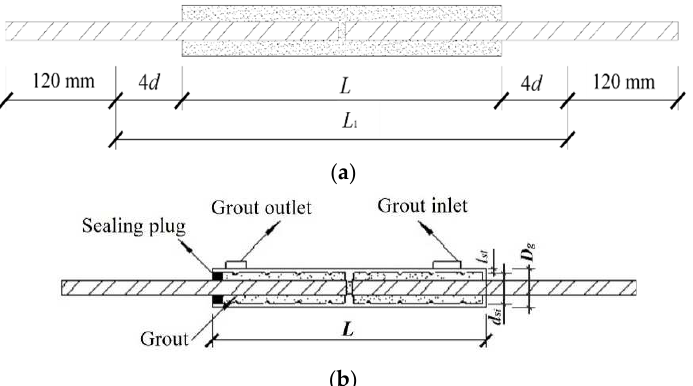
Figure 1. Schematic diagrams of grout sleeve. ( a ) Dimensions of grout sleeve and rebar. ( b ) Details of grout sleeve. Figure 2. Schematic diagrams of grout sleeve. Table 1. The dimensions of the sleeves.